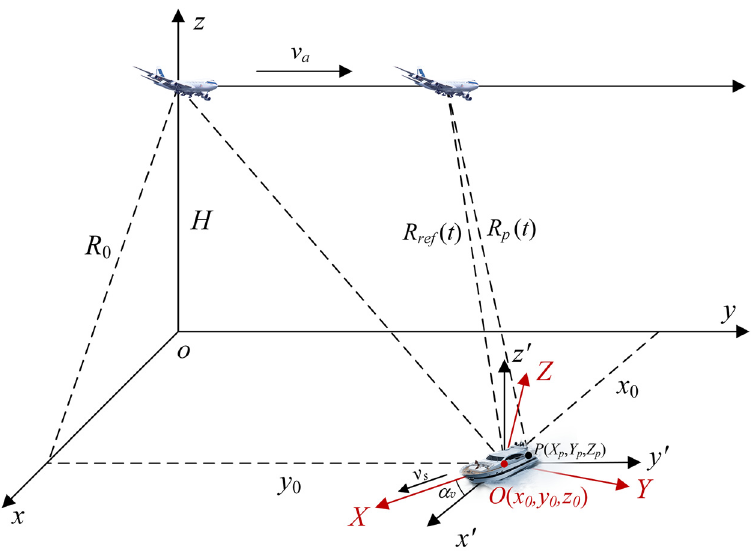
Figure 2. The geometry of a ship target. The o - xyz represents the fixed space coordinate system.